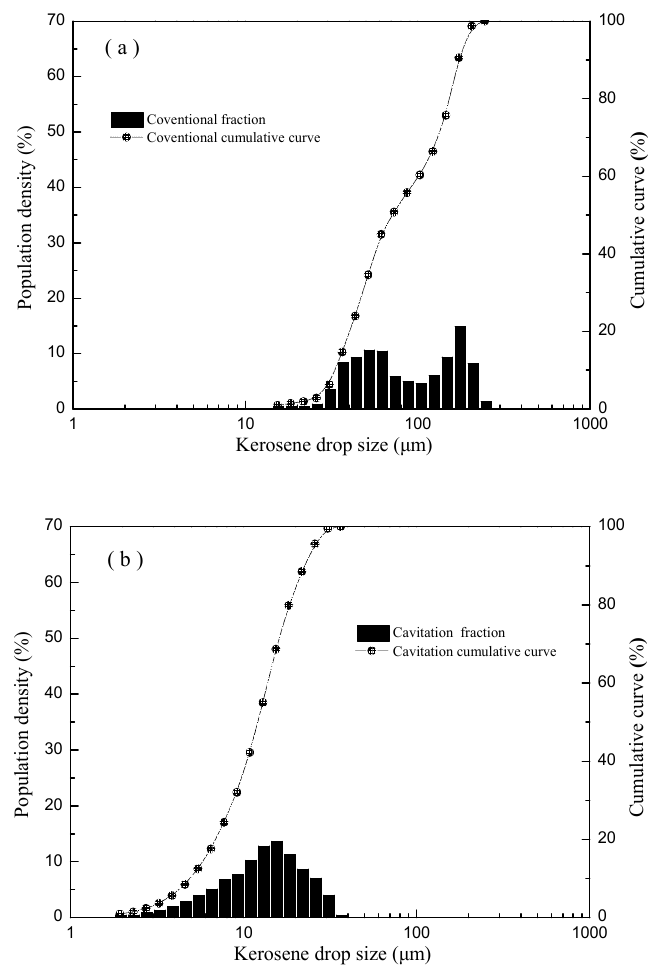
Figure 11. Size fraction of the collector: ( a ) Conventional agitation; ( b ) HC-assisted agitation.